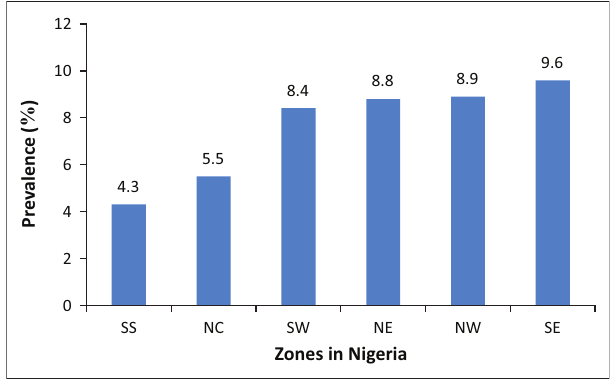
FIG URE 4: Prevalence of visual impairment by